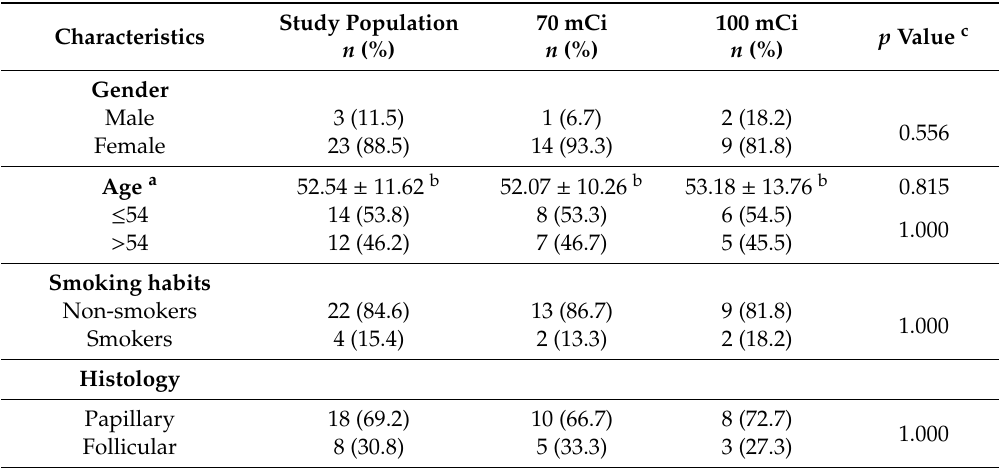
Table 2. General characteristics for di ff erentiated thyroid carcinoma (DTC) patients treated with 70 mCi ( n = 15) and 100 mCi ( n = 11) 131